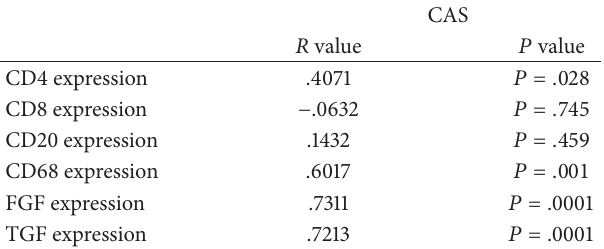
Table 4: Pearson’s correlation of CAS values with examined param-